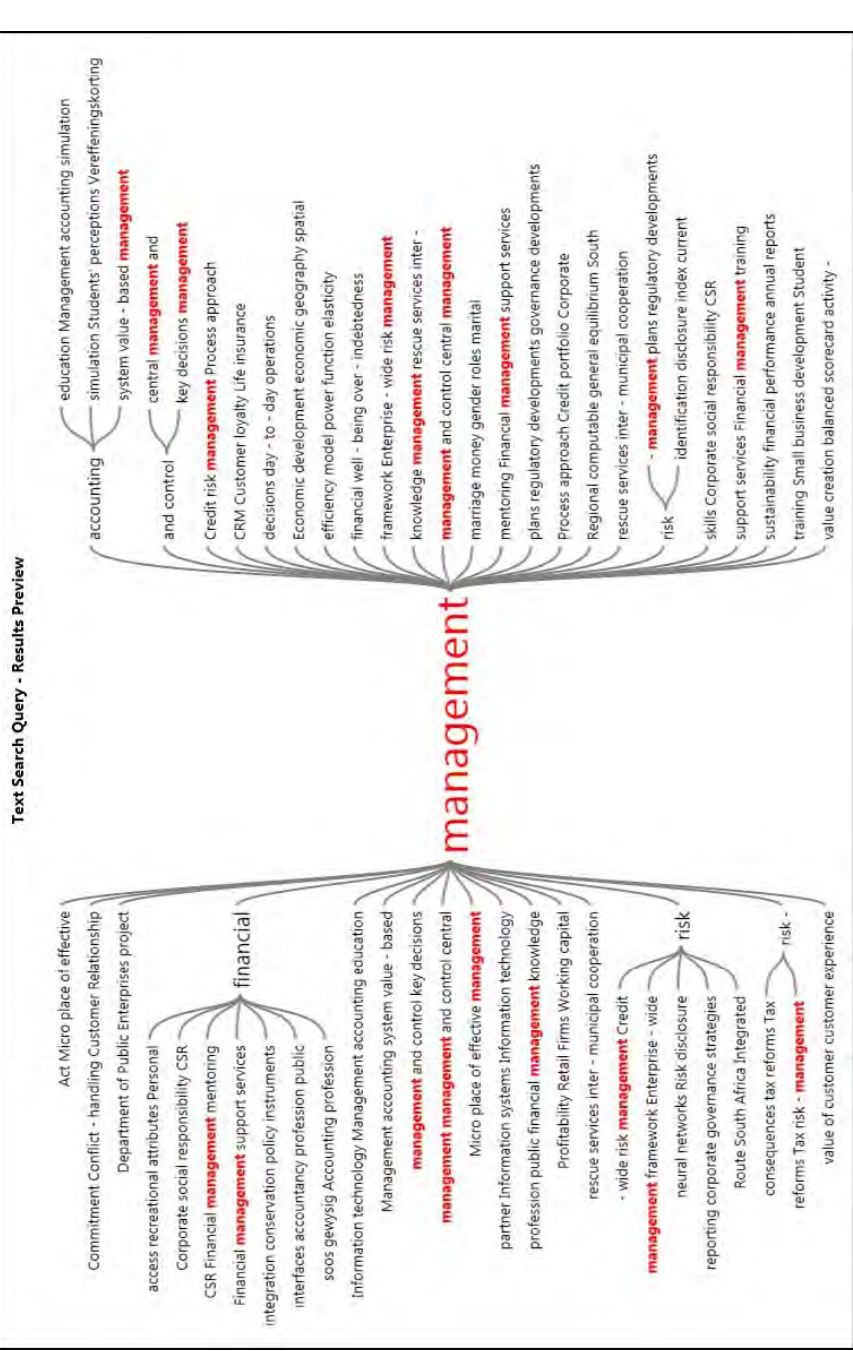
FIGURE 6: Word Tree Diagram: ‘Management’ Source: